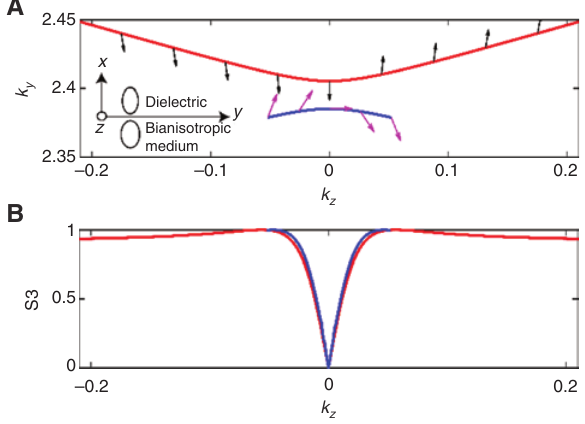
Figure 4: Polarization properties of the surface waves. (A) In-plane polarization states of the two band surface waves at the dielectric material/bianisotropic metamaterial interface. The red and blue lines indicate the two surface arcs, respectively. The black and magenta arrows in the upper and lower bands denote the in-plane polarization direction, respectively. The inset picture shows that the polarization states on both side of the interface are elliptical and the in-plane polarization plane is perpendicular to the propagation plane. (B) Stokes parameters S3 of the upper and lower bands of the surface wave in the bianisotropic metamaterial is plotted by red and blue lines,